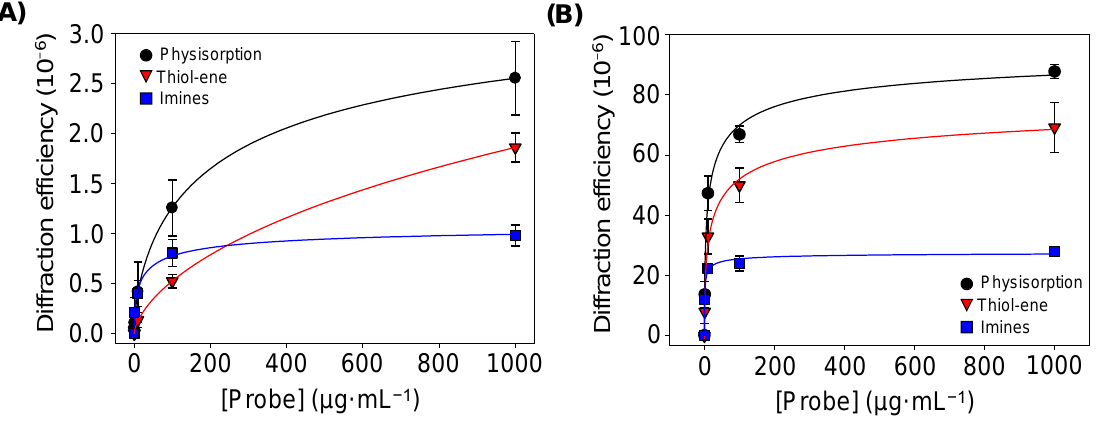
Figure 6. Diffraction efficiencies of the BSA patterns ( A ) before and ( B ) after incubating specific antiBSA IgG (10 µ g · mL − 1 ), created by increasing concentrations of BSA in the inking solutions. All trends correlated well with 4-parameter logistic curves (R 2 = 0.998). See Figure S7 for a zoomed view of both graphs in their low-concentration range.